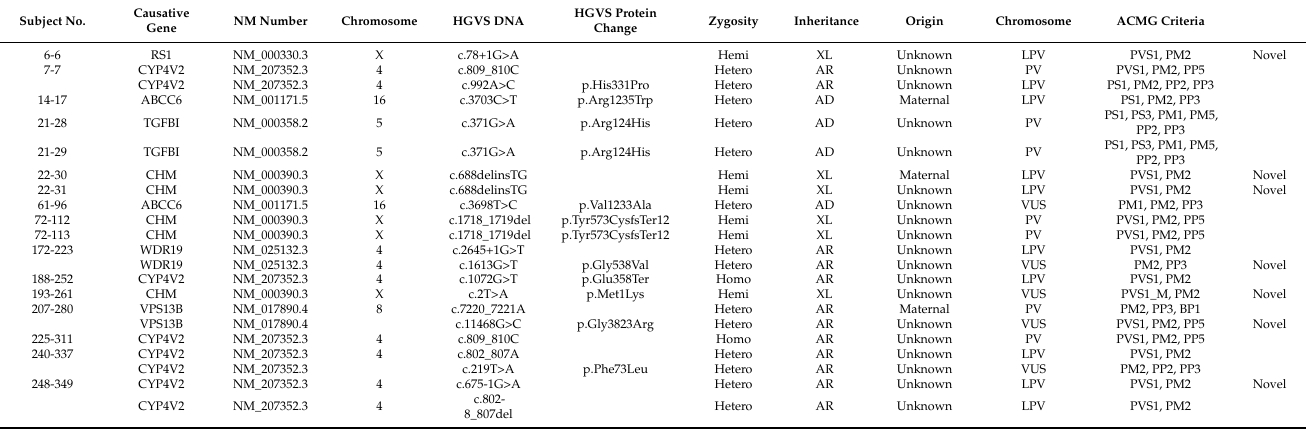
Table 3. List of patients with unexpected genetic results causing inherited retinal diseases other than retinitis pigmentosa.